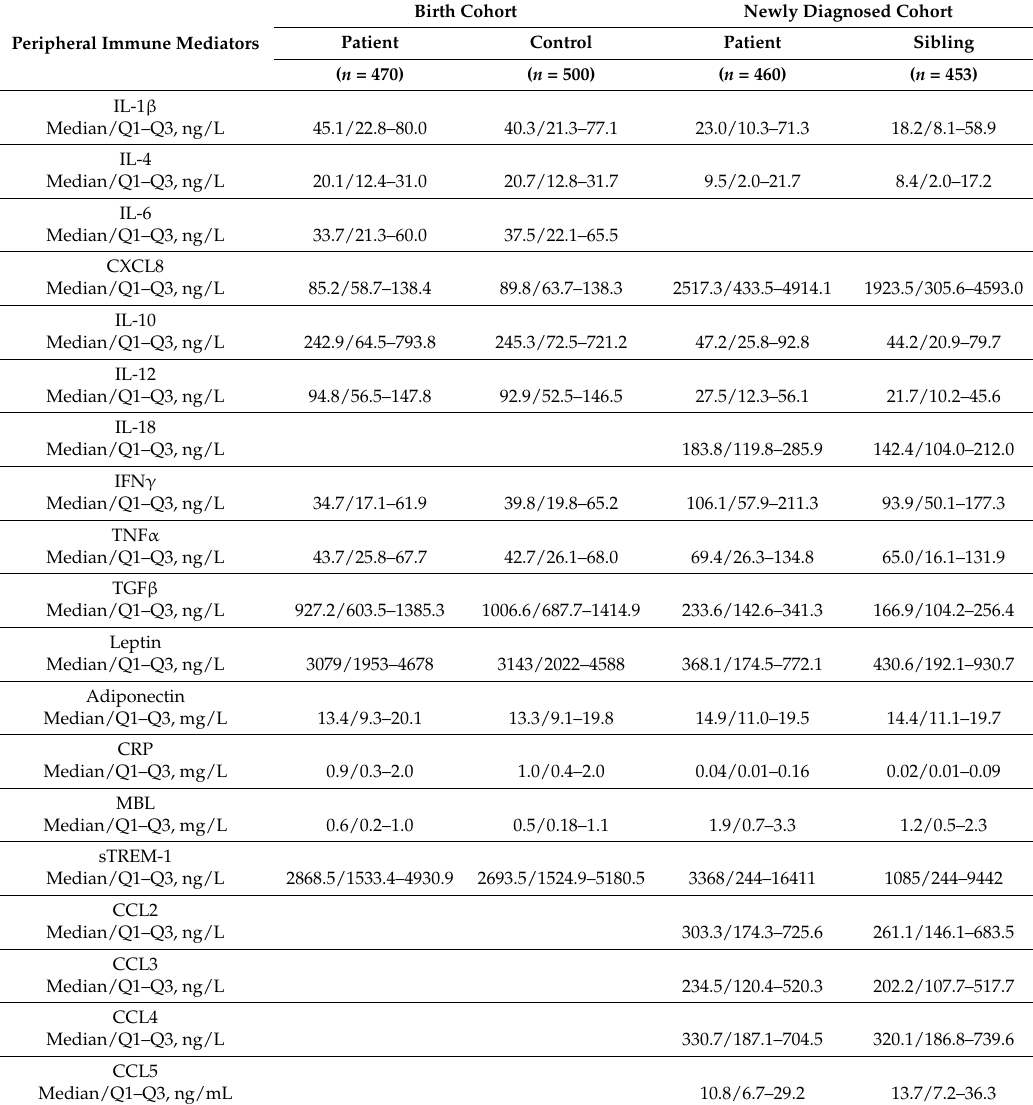
Table 2. Absolute levels of peripheral immune mediators stratified by cohort and case